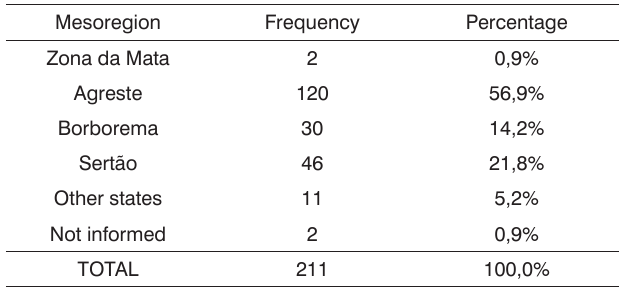
Table 3. Distribution and frequency of the population per region of residence.